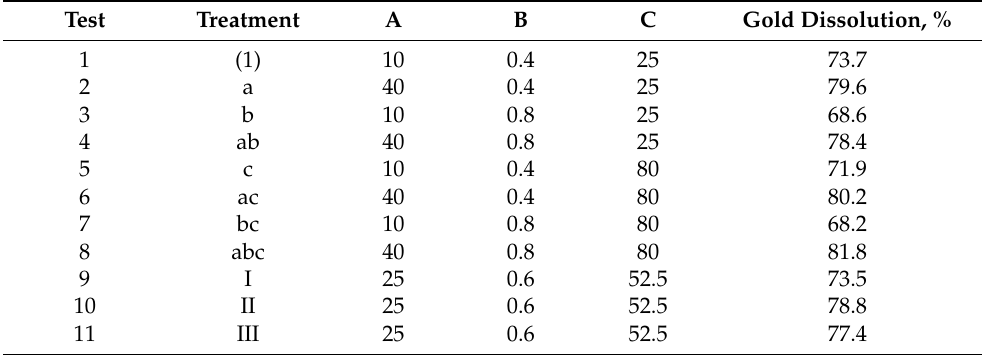
Table 6. 2 3 full factorial design with replicated central point (A: thiourea, g/L; B: Fe 3+ , % w / v ; C: temperature, ◦ C).